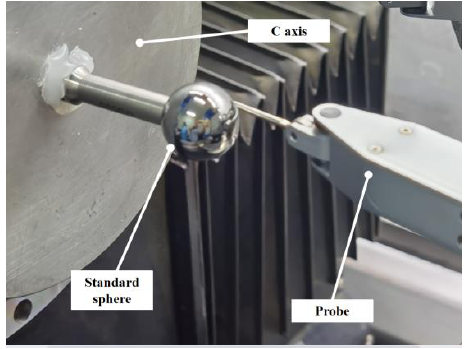
Figure 12. Profile measurement setup of a standard sphere.